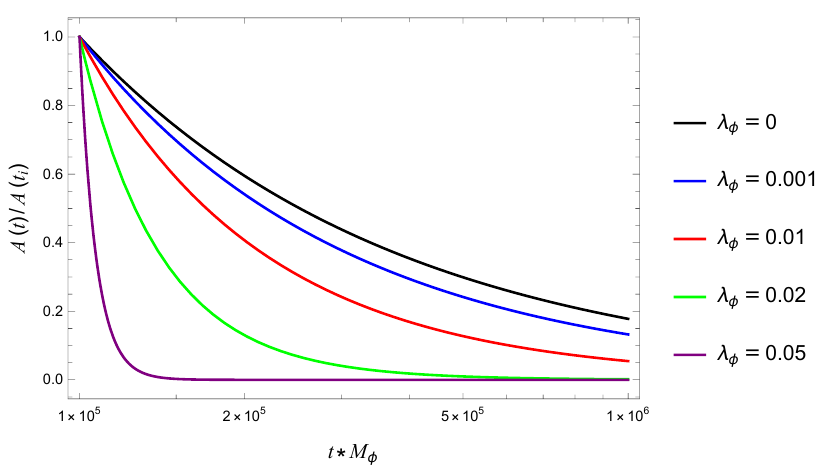
Figure 10 . Numerical solutions of the condensate equation (4.5) with M pl /M φ = 10 9 , g ∗ = 100 , and various values for λ φ . The initial condition A ( t i ) /M φ = 1 is set at t i M φ = 10 5 . The parameters have been chosen in such a way that eq. (4.8) is